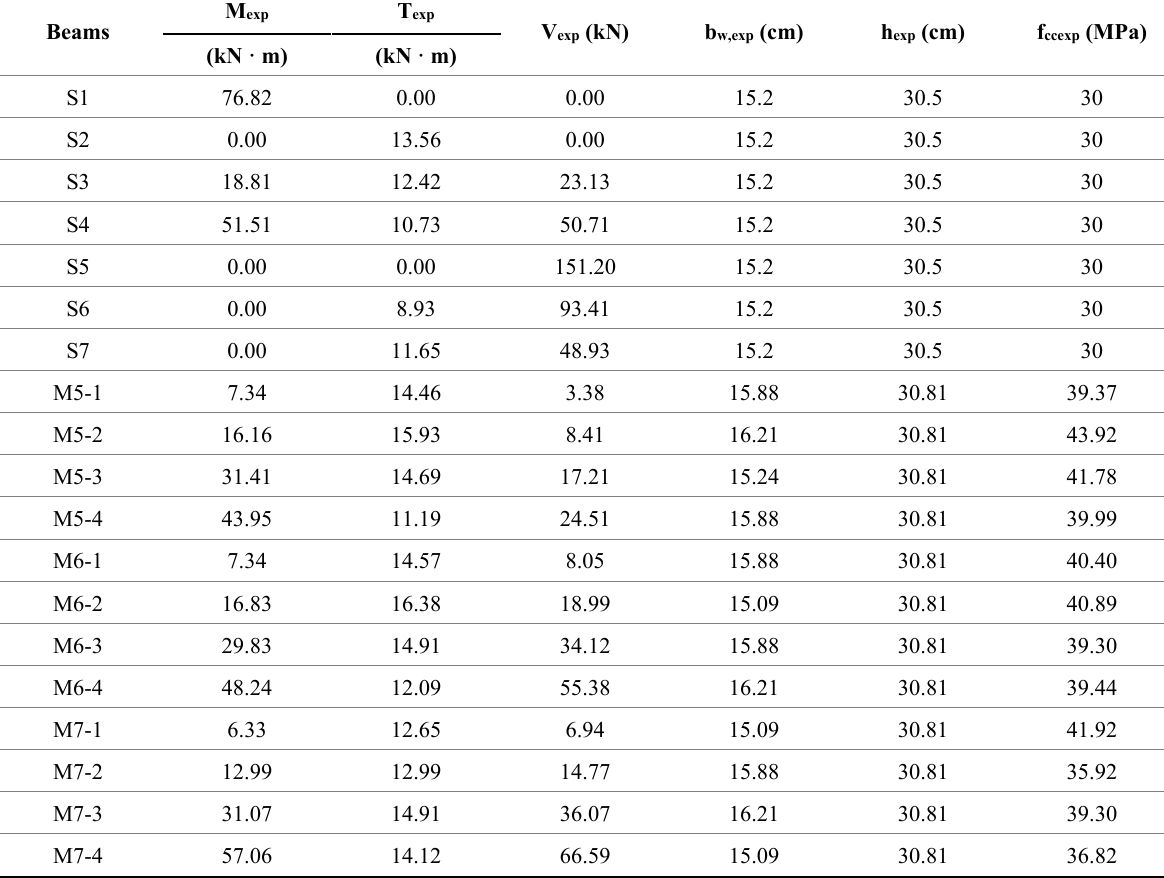
Table 2: Test results [20], [21].